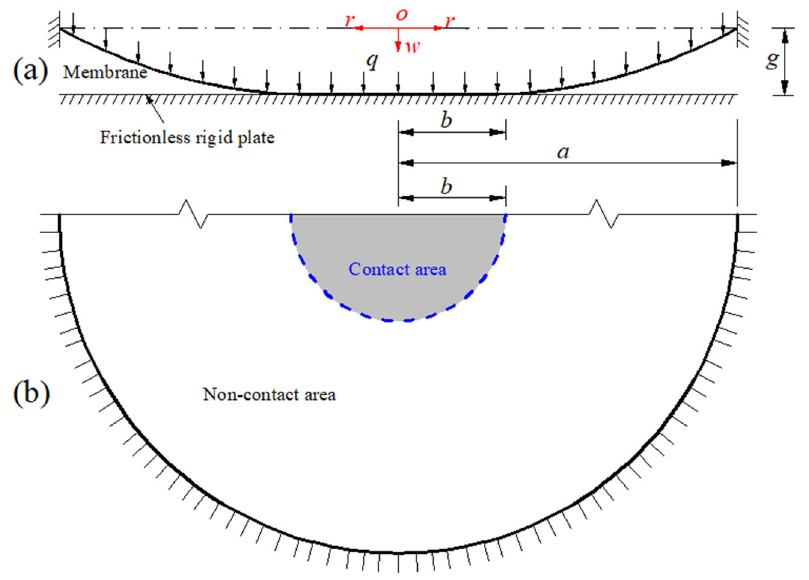
Figure 1. Sketch of a deflected circular membrane in contact with a frictionless rigid plate: ( a ) cross-section view along a diameter, and ( b ) half of plan view. In the plate/membrane non-contact annular area, a free body of radius b ≤ r ≤ a is taken from the annular portion of the deflected circular membrane to study its static over the cross section of the deflected membrane) and θ is the rotation angle of the deflected membrane, the meridional rotation angle.